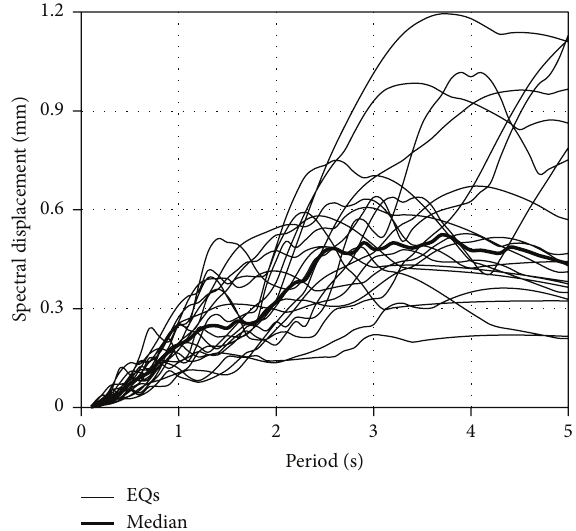
Figure 4: Median and record displacement response spectrum for SAC La 10 in 50 suite.